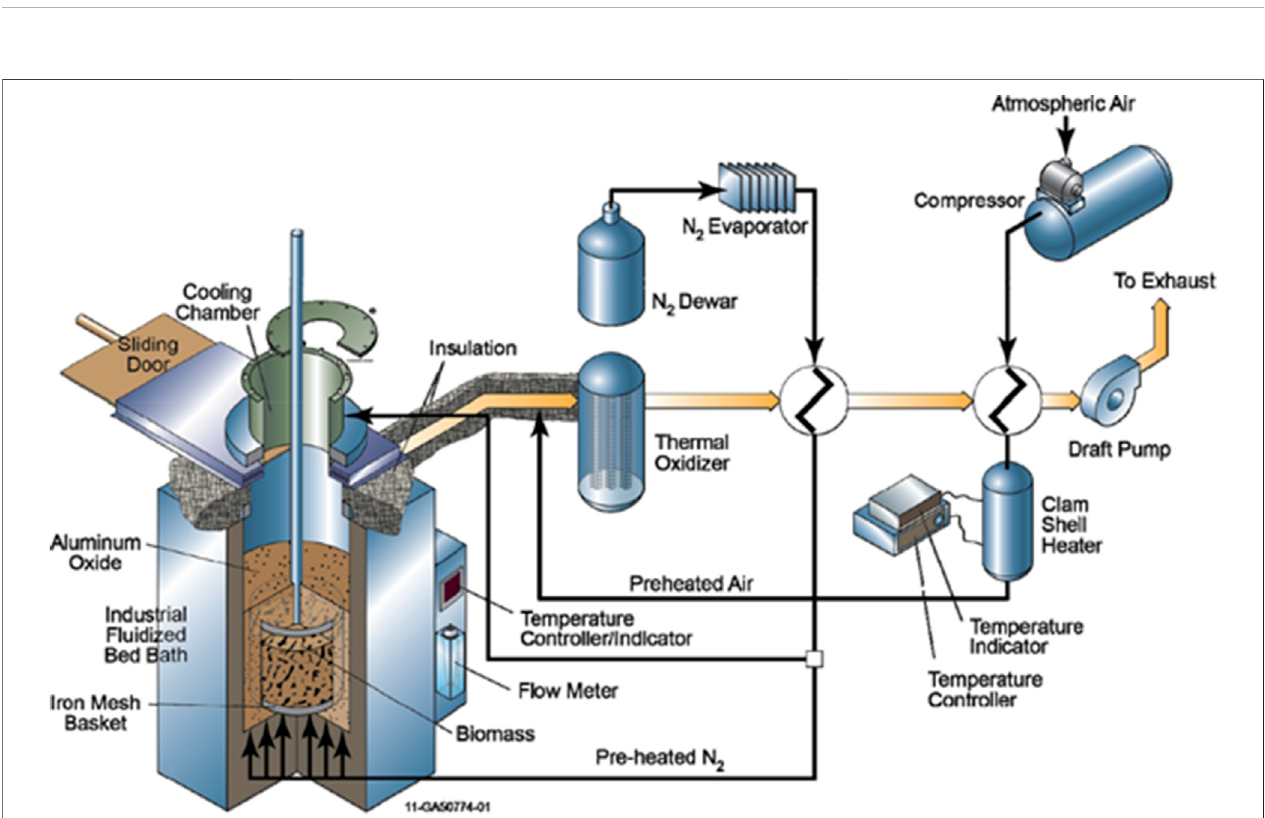
FIGURE 6 | Fixed bed reactor for biomass torrefaction (Tumuluru, et al. 2012a).